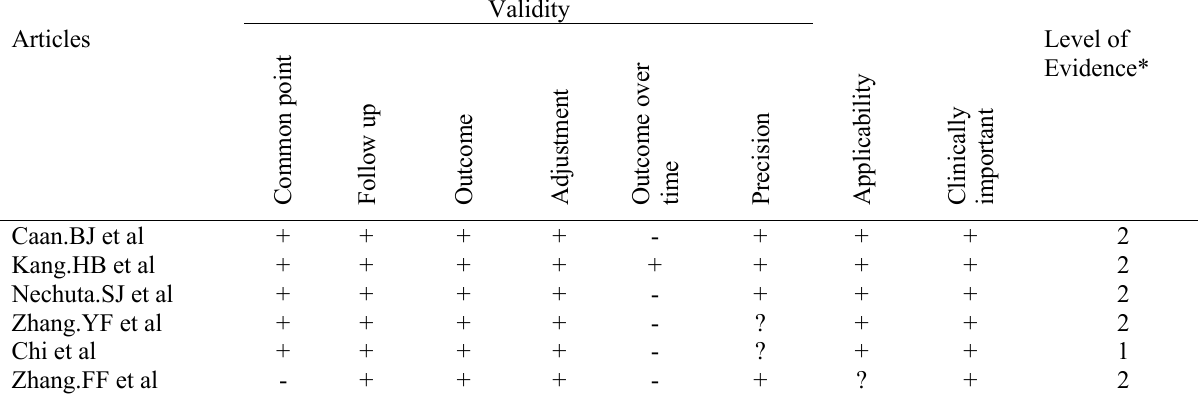
Table.3 Critical apprisal of the six studies based on criteria by Center of Evidence-Based Medicine,